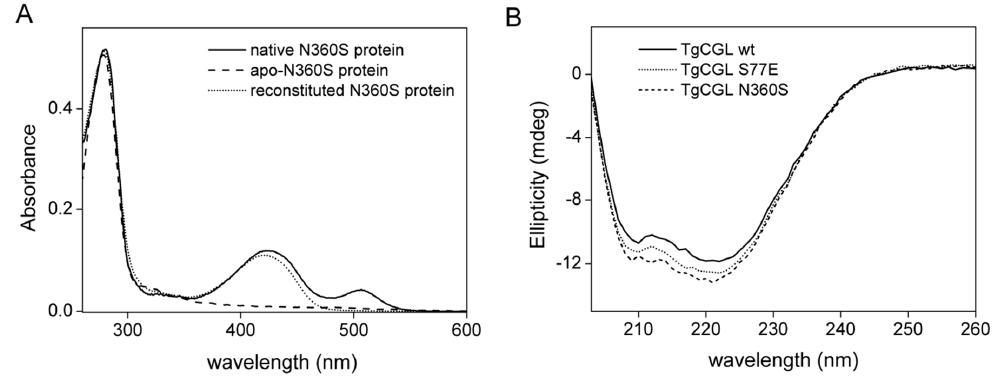
Figure 6. Properties of TgCGL N360S variant. ( A ) UV–visible absorption spectra for native N360S enzyme after purification (solid line), apo-protein (dashed line), and reconstituted holo-enzyme (dotted line). ( B ) Far-UV CD spectra of TgCGL wild type (solid line), S77E (dotted line) and N360S (dashed line) variants.